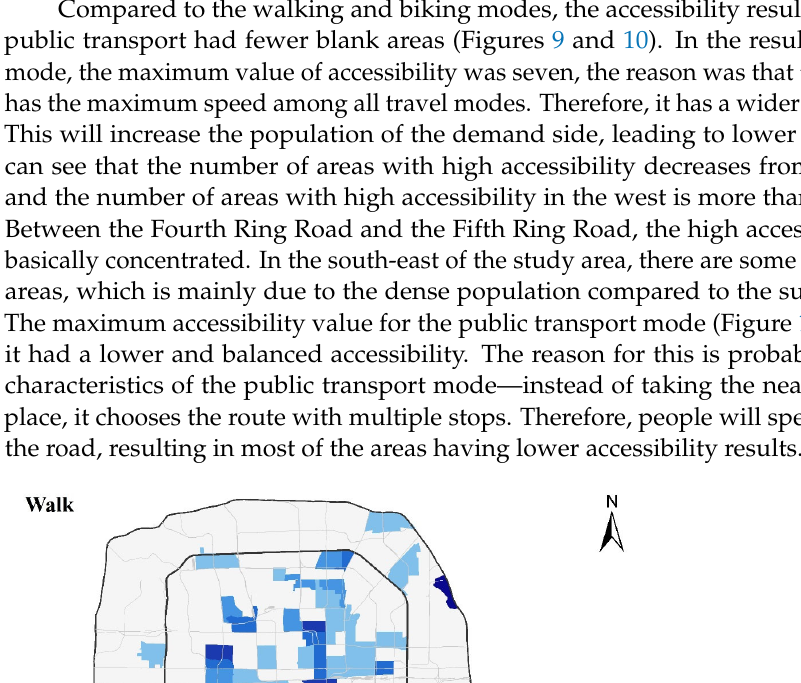
Figure 8. The accessibility results of biking.